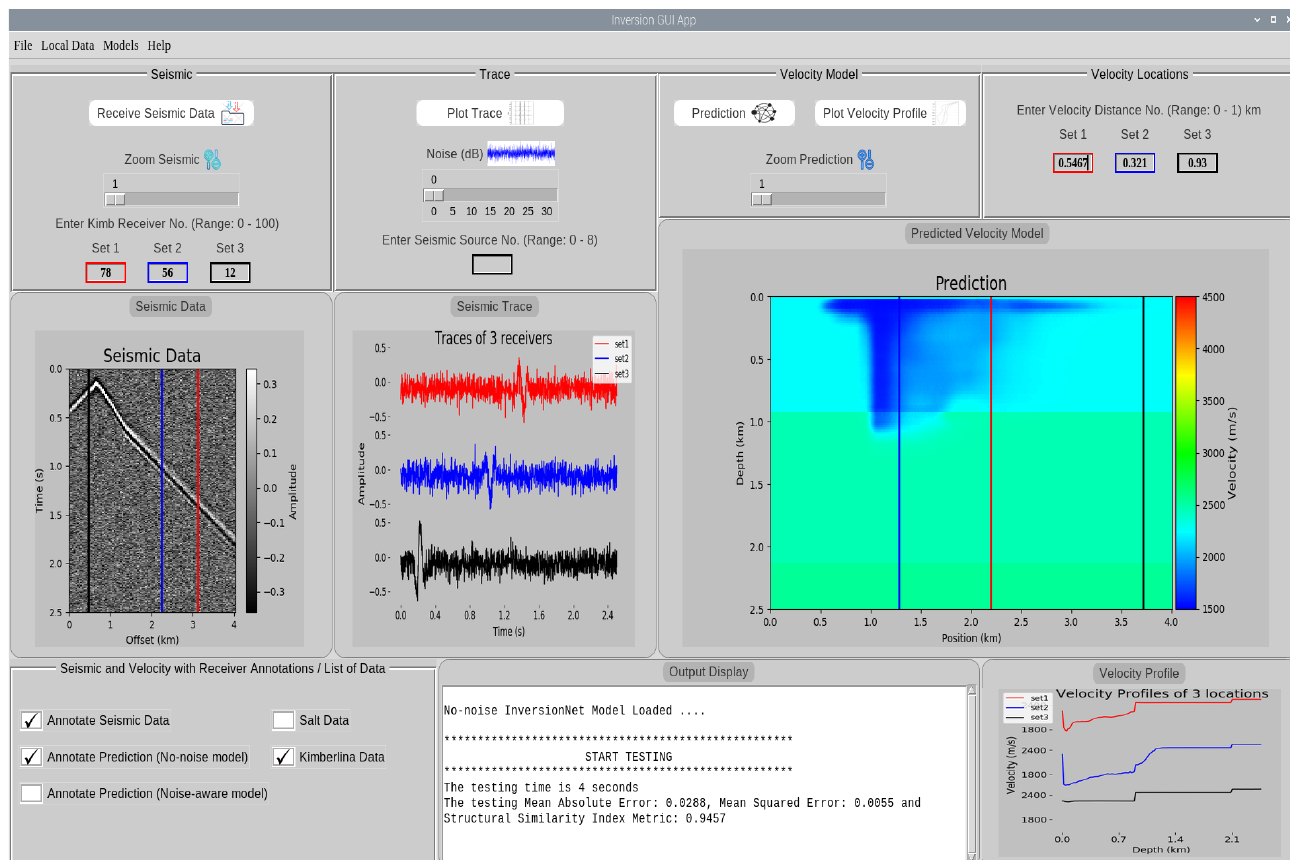
Figure 8. Interface of the designed graphical user